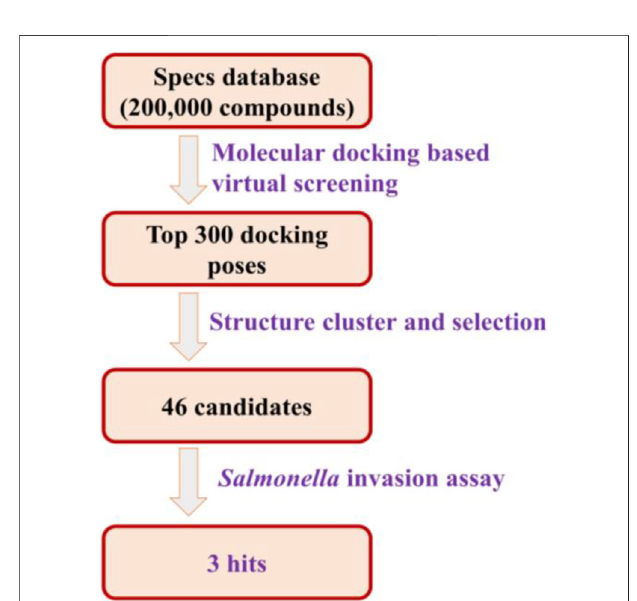
FIGURE 2 | The work fl ow of the virtual screening.